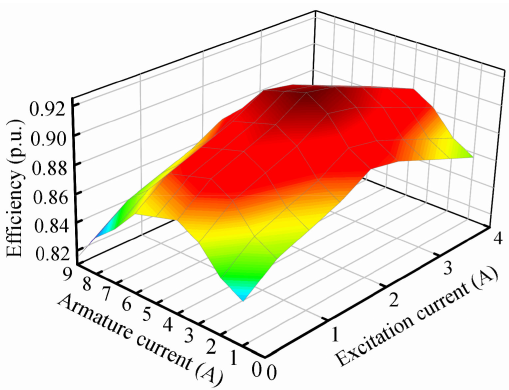
Figure 17. Three-dimensional efficiency